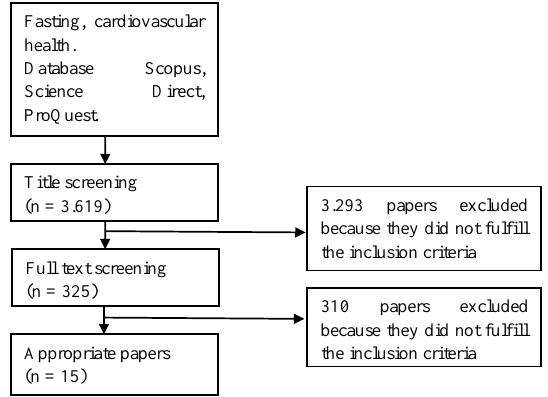
Figure 1. Flowchart of the research benefits of fasting to improve health conditions and disease prevention in relation to the cardiovascular